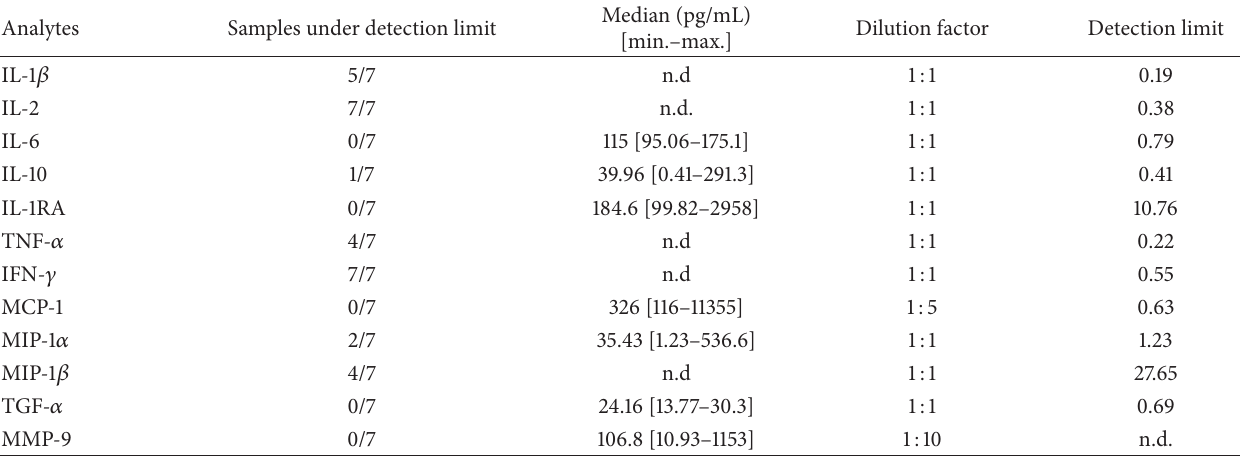
Table 3: CSF inflammatory parameters in control patients ( 𝑛 = 7